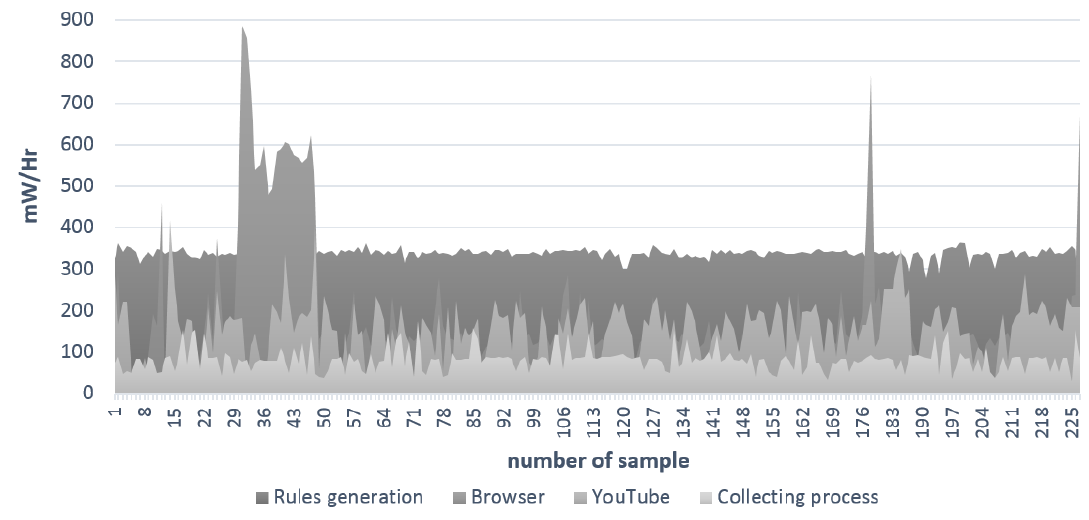
Figure 16. Comparison chart between different processes’ consumption.